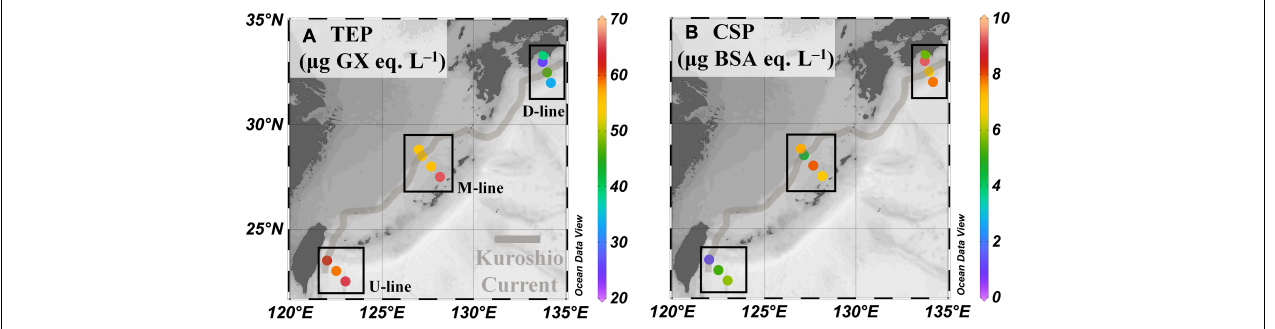
FIGURE 4 | Exopolymeric particle variables in the Kuroshio region observed during the KH-15-4 cruise. (A,B) Concentrations of transparent exopolymer particles (TEP), and Coomassie stained particles (CSP), respectively. Data are shown as in Figure 2 and values are shown in Table 2 .